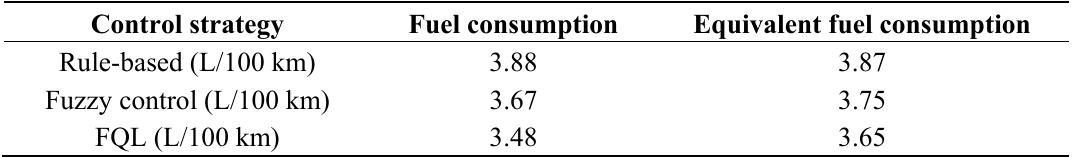
Table 4. Compare results under UDDS.